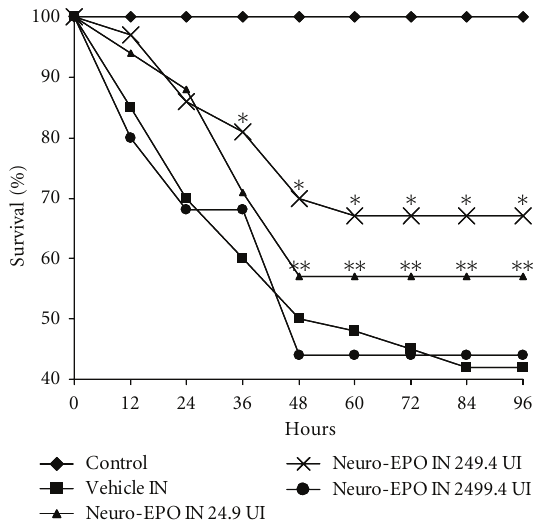
Figure 1: Percent of survival in ischemia model in Mongolian gerbil, evaluating di ff erent doses of intranasal formulation of Neuro-EPO ∗ ( P < 0 . 01); ∗∗ ( P ,0.02) indicate significant di ff erence in Kaplan Miller Test respect with vehicle ( n = 35 per group).